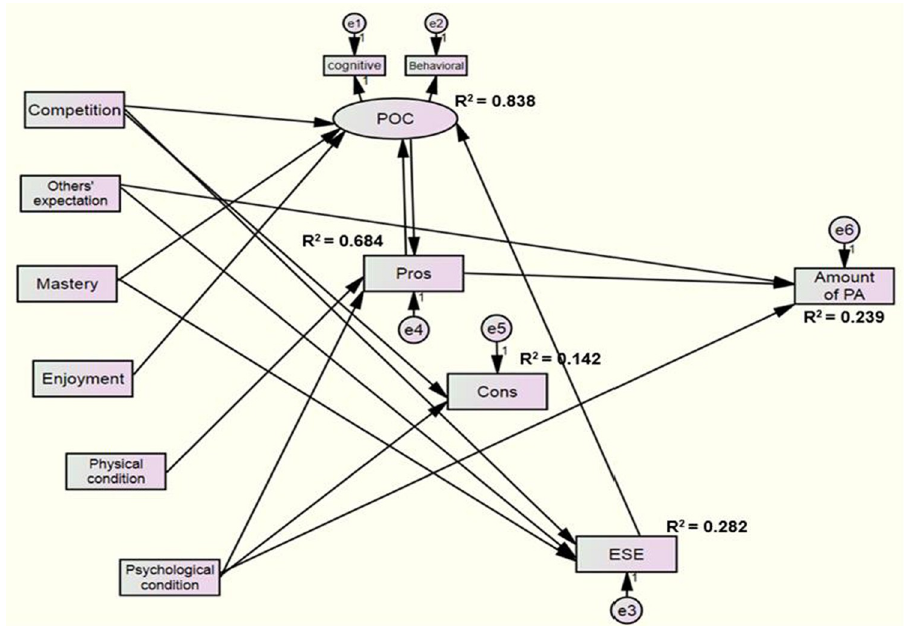
Fig 2. Final model for the SEM of TTM, motives for PA, and amount of PA.